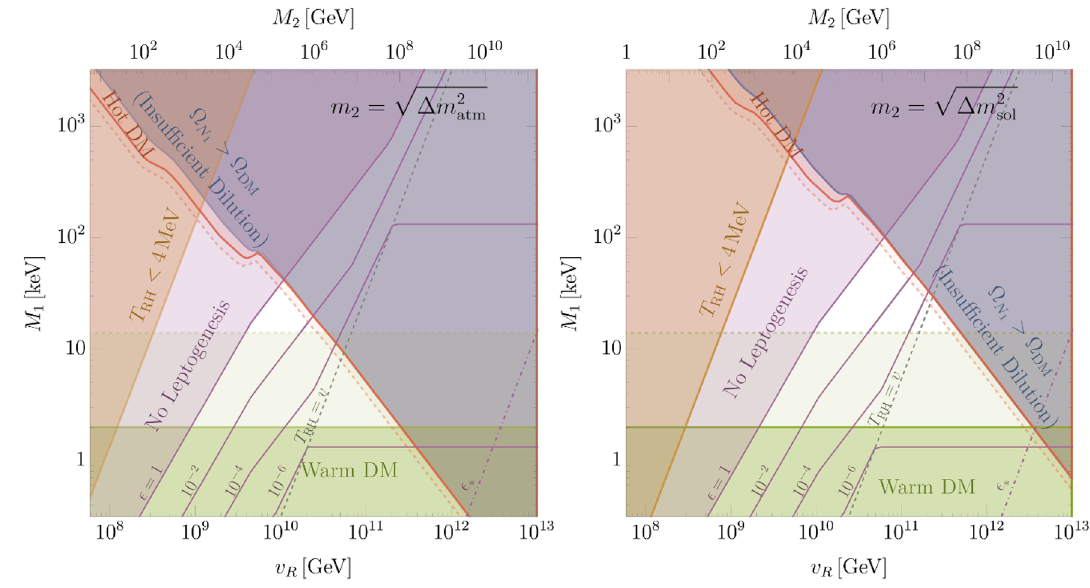
Figure 4 . Purple contours of the asymmetry parameter, (cid:15) , required to produce the observed baryon asymmetry, Y B ’ 8 × 10 − 11 in the freeze-out cosmology. Larger values of (cid:15) are required as M 1 increases due to the greater dilution necessary to realize N 1 dark matter. Likewise, larger values of (cid:15) are required at low v R when T RH is below the weak scale, as indicated by the dashed gray line. In this regime, the baryon asymmetry is generated only by N 2 that decay at temperatures above the weak scale, where electroweak sphalerons are operative. To the left of the dot-dashed purple contour, the baryon asymmetry can only be realized when (cid:15) is greater than its natural maximum, (cid:15) ∗